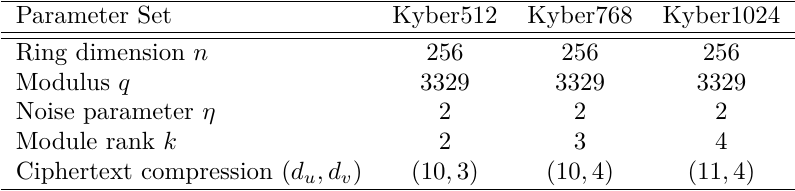
Table 2: Kyber parameter sets (second round) [ABD + 19]